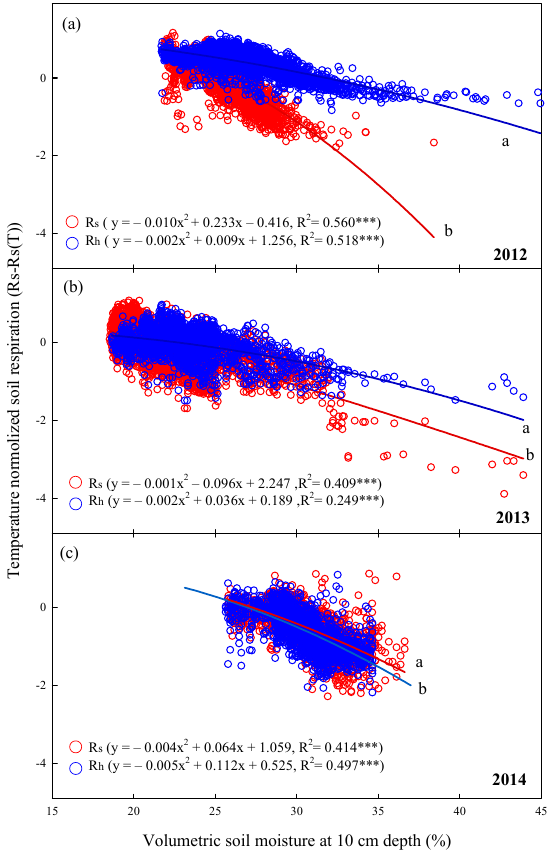
Figure 8. Relationships between half-hourly temperature-normalized soil respiration (Rs) and heterotrophic respiration (Rh) and hourly volumetric soil moisture at 10 cm depth (%) in summer (June–August) in ( a )2012, ( b ) 2013, and ( c ) 2014. Asterisks indicate significance: *** p < 0.001. Different letters indicate differences between regression lines within the same year at p < 0.05.